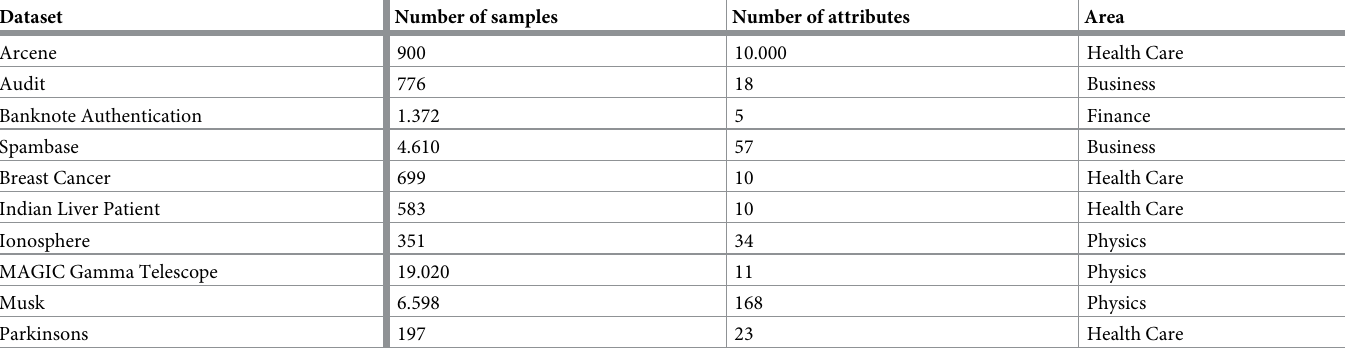
Fig 2. The GSDOT data generation mechanism when positive class samples are generated. The process is repeated for the negative class. classification models [23]. Accuracy measures the ratio of correct predictions over the total number of instances. The mathematical formula is the following: where TP , TN , FP , FN denote the number of correctly classified positive, negative and misclas- sified negative, positive instances, respectively. Accuracy might be inappropriate for datasets with a significant difference between the number of positive and negative classes since rare classes have a small impact to the final outcome compared to the majority classes. To make Table 1. Description of the datasets.